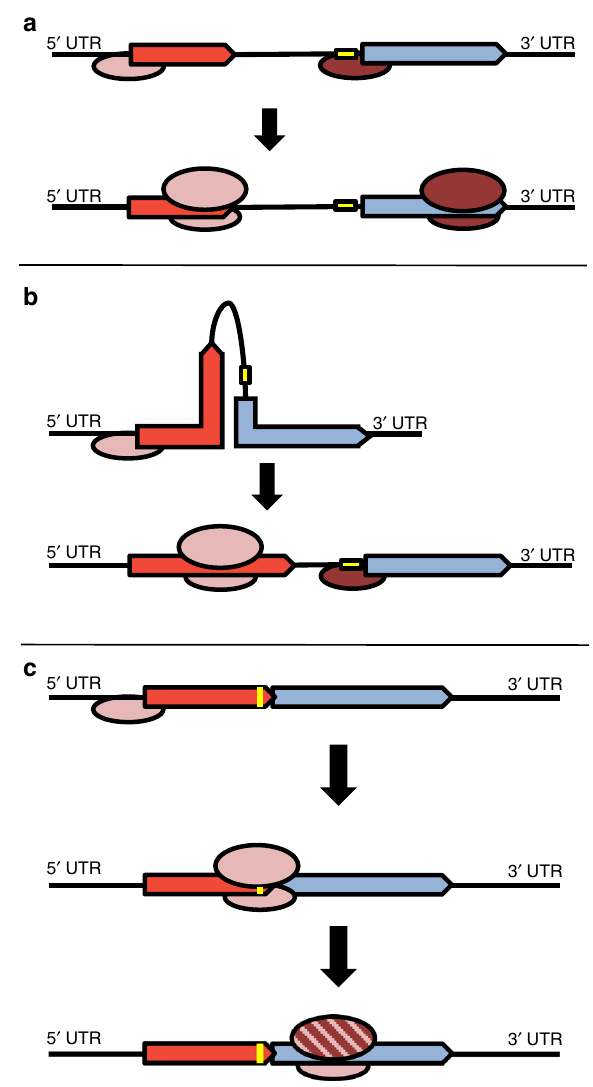
Fig. 1 Three mechanisms of translation initiation at polycistronic mRNAs. a No translational coupling. Genes with intergenic regions, independent translation initiation at all genes. b Translational coupling (UTNI mechanism). Genes with intergenic regions. Translation of the downstream gene is inhibited due to long-range interactions. Translation of the upstream gene destroys these structures and enables do novo initiation at the downstream gene. c Translational coupling (TeRe mechanism). Genes with overlaps of stop and start codons. The same ribosome that terminates translation of the upstream gene (or the same 30S subunit)